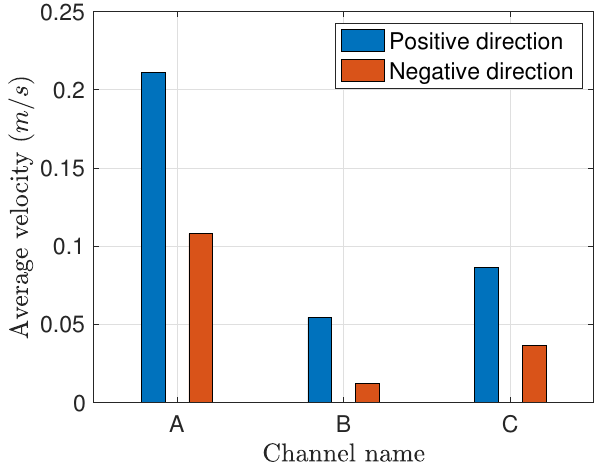
Figure 16. Influence of the pattern geometry on the average velocity of the front in the positive x direction. The contact angle is θ =